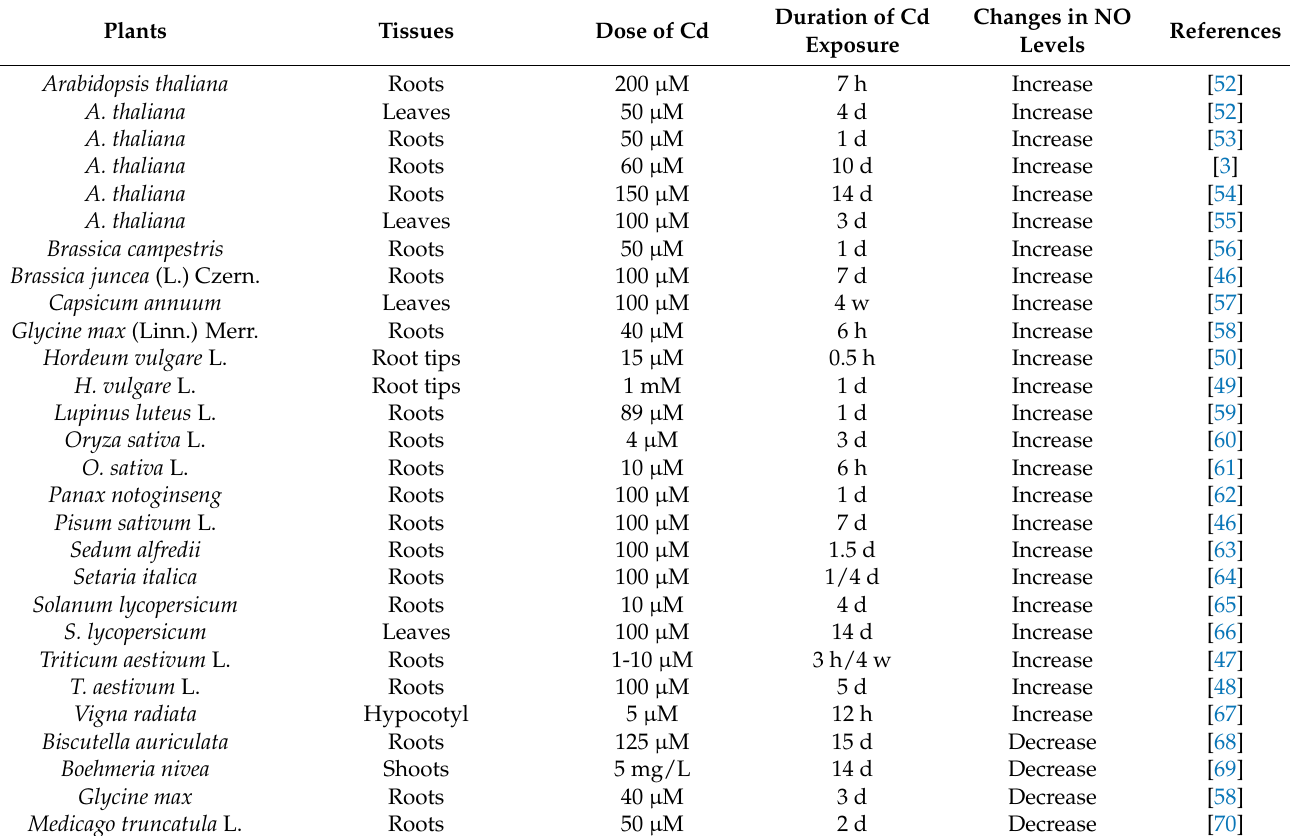
Table 1. Effect of Cd stress on NO levels in different